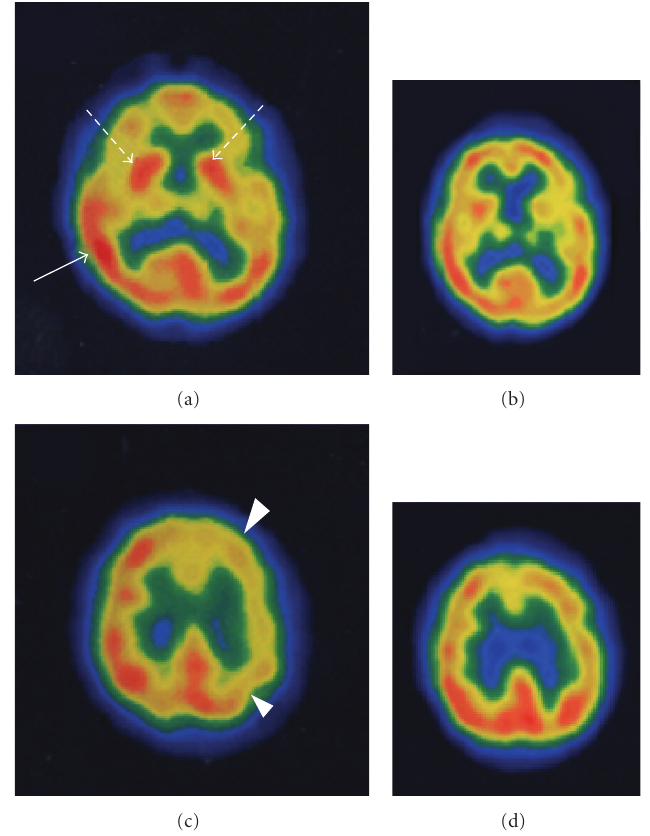
Figure 1: 99 m -HMPAO-SPECT images acquired during a seizure and 10 days later. (a) and (c) show relative hyperperfusion in the right parietal lobe (arrow) and both thalami (dotted arrows) and relative hypoperfusion in the left prefrontal and parietal lobes (arrow heads) during a seizure. (b) and (d) are the same axial slices as (a) and (c), respectively, obtained 10 days after the final seizure. In (b) and (d), relative hyperperfusion and hypoperfusion are not noted, as bilateral symmetrical cerebral perfusion has been